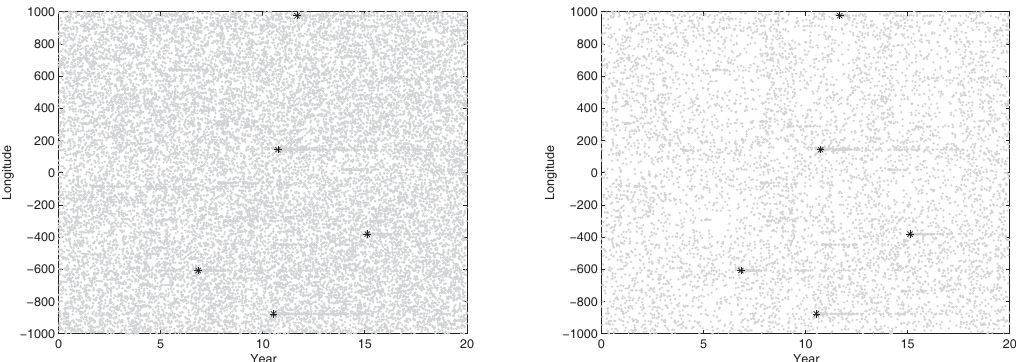
Fig. 6. Plot of space vs. time for (left) the synthetic catalog presented in Fig. 3 (top left), (right) declustered synthetic catalog obtained with the proposed tri-stage cluster identification model presented in Fig. 5 (bottom left). Estimated Af. Model Estimated Bg. Model Catalog Data (Af.+ Bg.) True Bg. True Af.